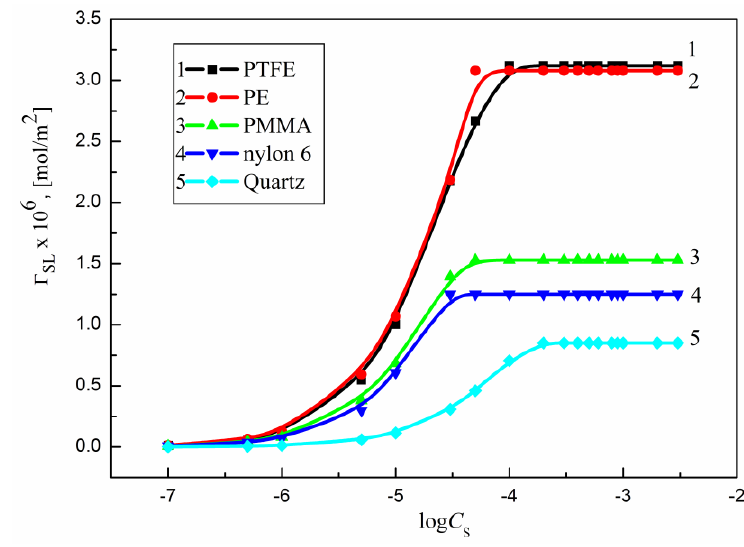
Figure 9. A plot of the SMD Gibbs surface excess concentration ( Γ SL ) (curves 1–5) at the PTFE, PE, PMMA, nylon 6 or quartz–water interfaces, respectively, vs. the logarithm of SMD concentration (log C S ).